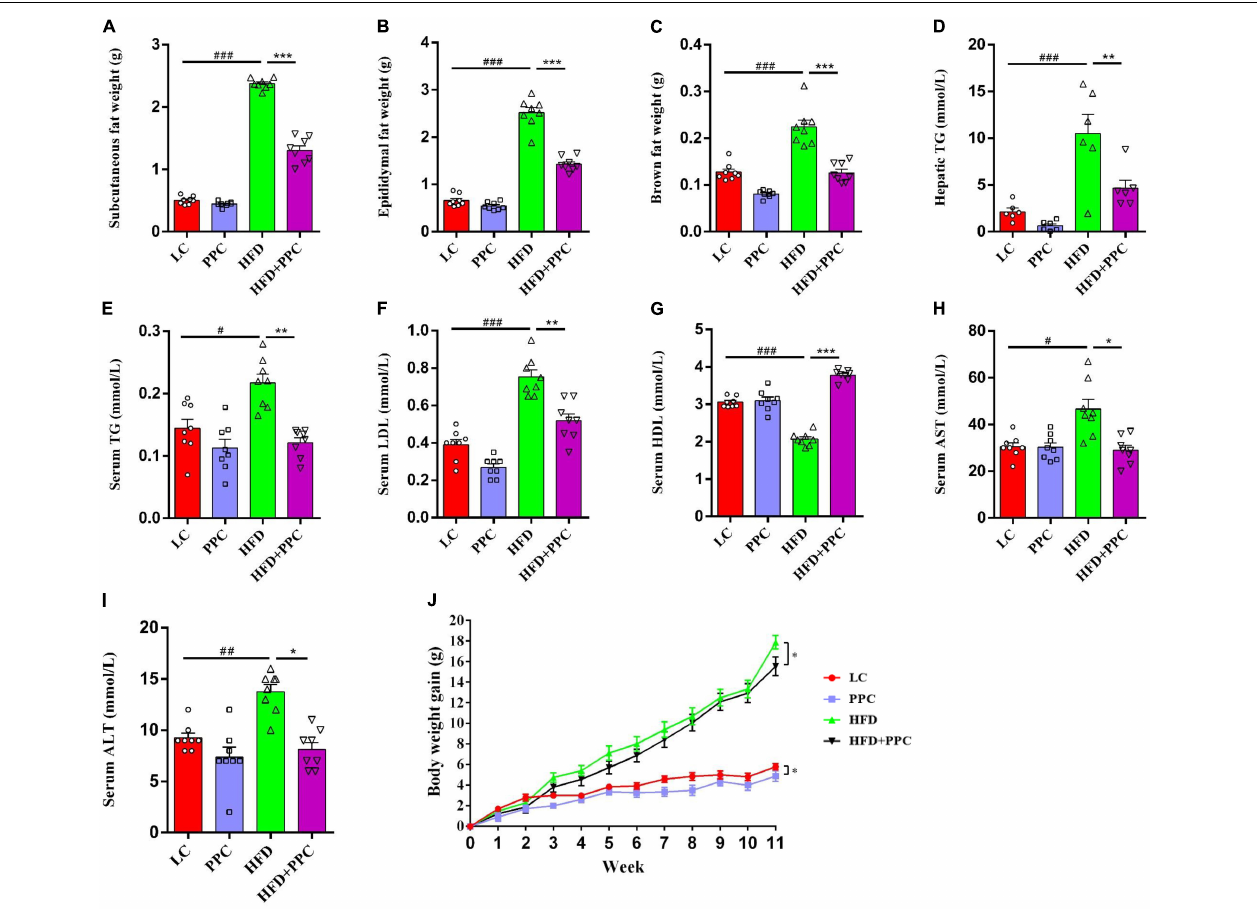
FIGURE 1 | PPC supplementation improves metabolic parameters in the mice fed by HFD. All the mice were sacrificed at 13th week. (A–C) The mass of subcutaneous fat, epididymal fat, and brown fat. (D) The hepatic TG level. (E–I) The serum levels of TG, LDL, HDL, AST and ALT. (J) The body weight gain. n = 8 mice for each group. The differences were analyzed using one-way or two-way ANOVA. Data represent means with SEM. The pound signs indicate statistically significant differences compared to the LC group. # P < 0.05, ## P < 0.01, ### P < 0.001. Asterisks indicate statistically significant differences compared to the